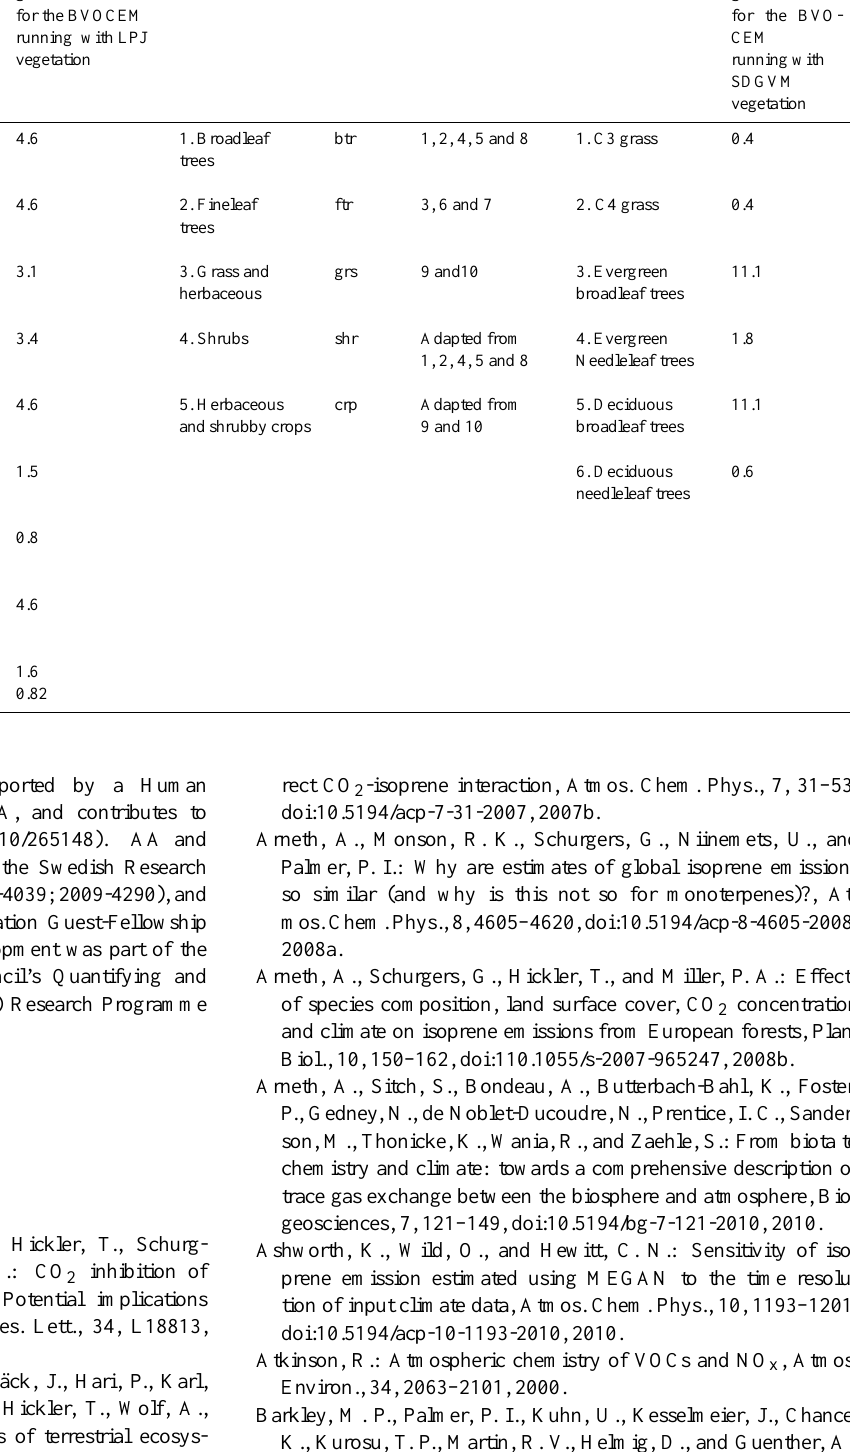
Table A1. Use of plant functional types and isoprene emission factors for simulations in this study (dm: dry matter). LPJ-GUESS